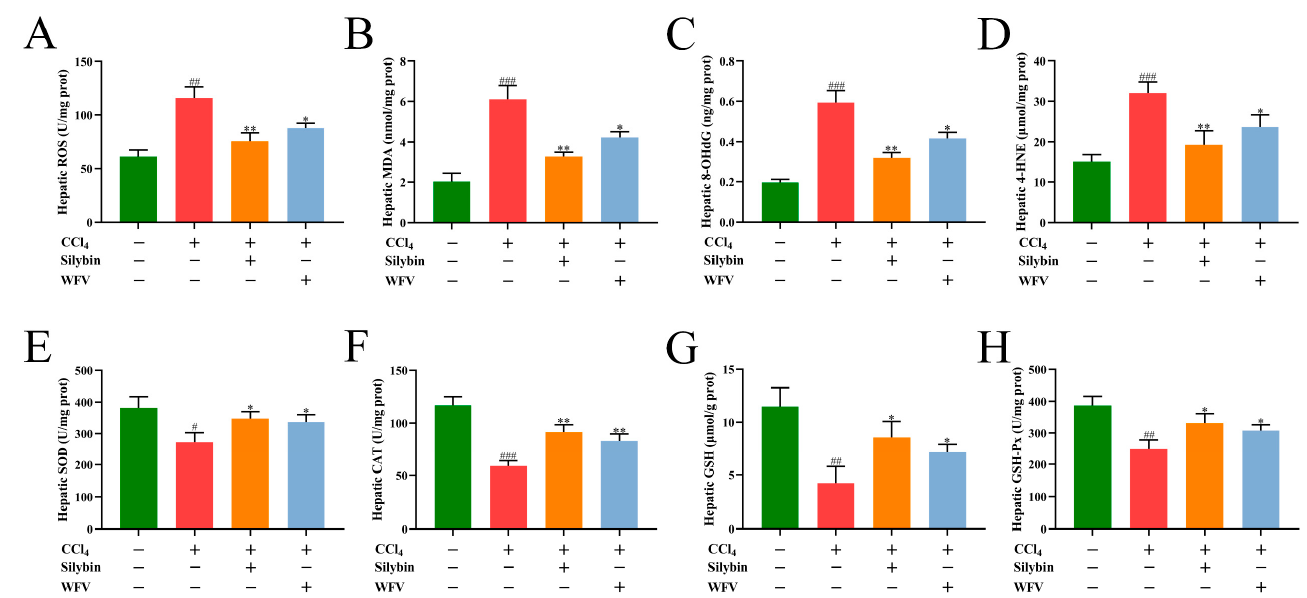
Figure 4. Effect of WFV on oxidative and antioxidative levels in mice with liver injury. Hepatic levels of ROS ( A ), MDA ( B ), 8-OHdG ( C ), 4-HNE ( D ), SOD ( E ), CAT ( F ), GSH ( G ), and GSH-Px ( H ) were detected by a microplate reader. # p < 0.05, ## p < 0.01, ### p < 0.001 vs. control group. * p < 0.05, ** p < 0.01 vs. model group.